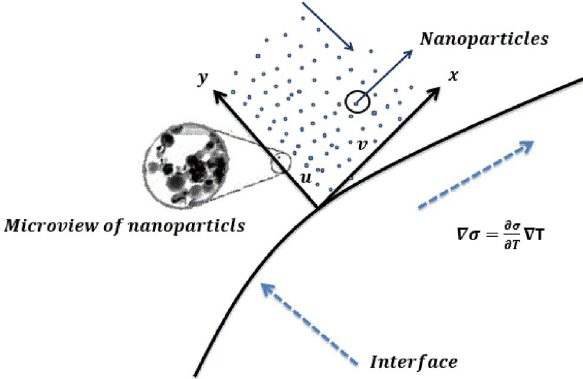
Figure 1. The modeled flow problem geometric